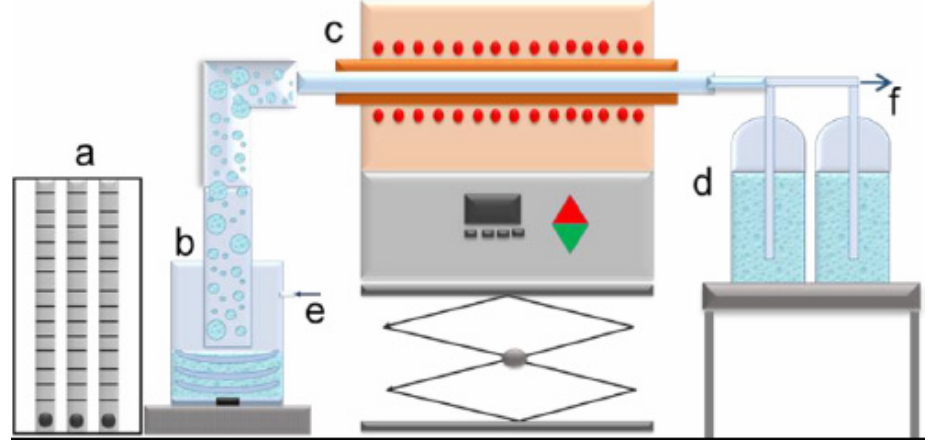
Table 1. Experimental parameters of ultrasonic spray pyrolysis method.